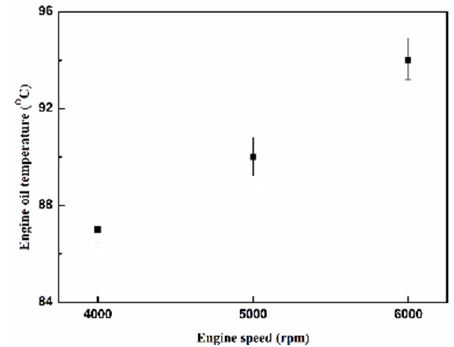
Figure 27. The oil temperature of the engine at different engine speeds.